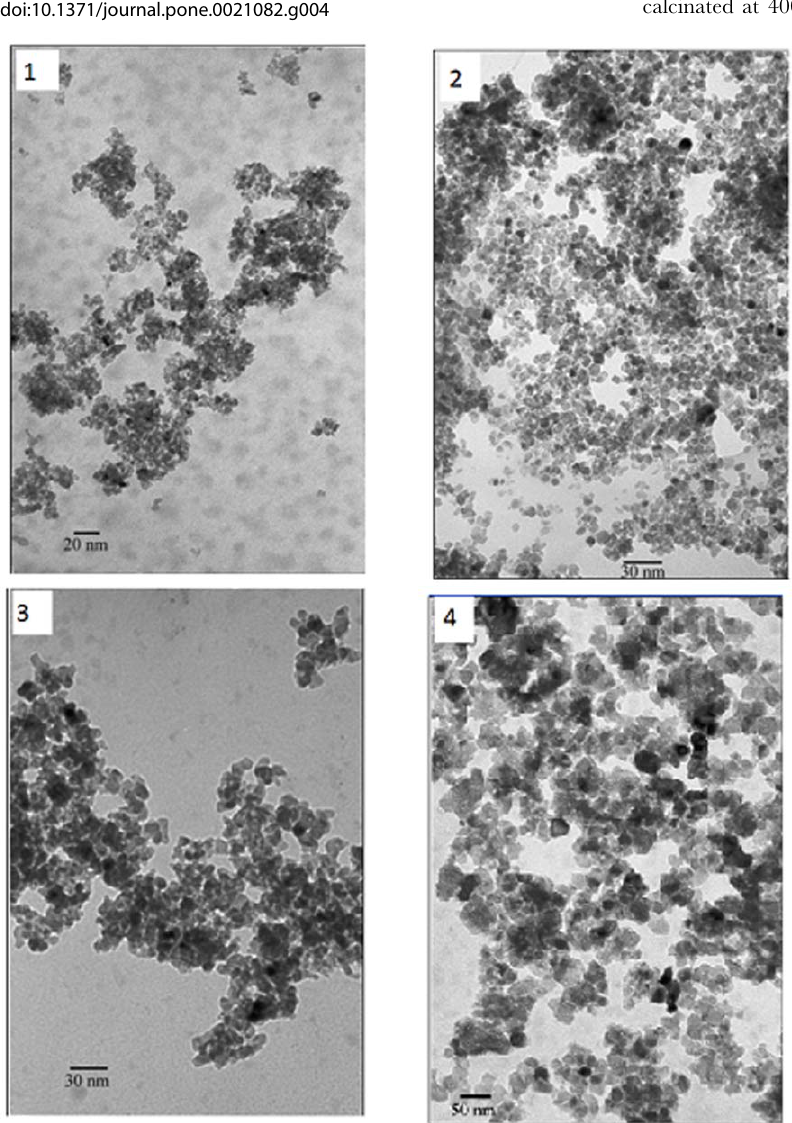
Figure 5. TEM image of the samples calcinated at 400 6 C for 2 hours: sample 1, sample 2, sample 3, sample 4. doi:10.1371/journal.pone.0021082.g005 PLoS ONE |